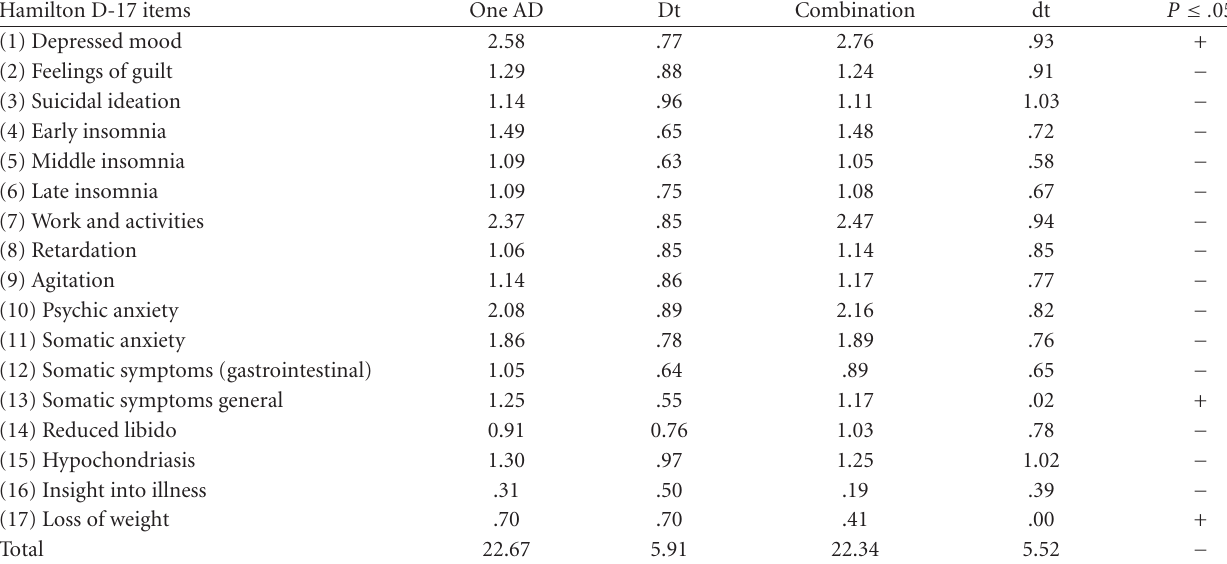
Table 5: Comparative study of Hamilton basal score one AD versus